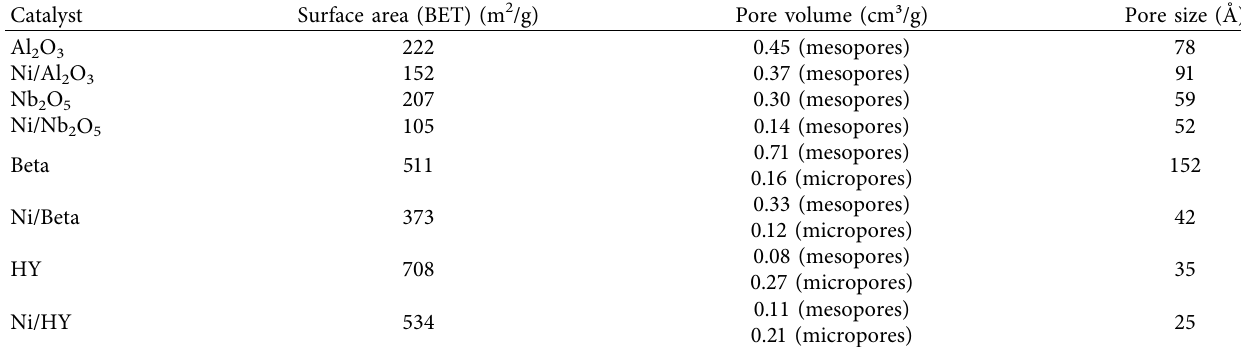
Table 1: Textural properties of the catalysts and